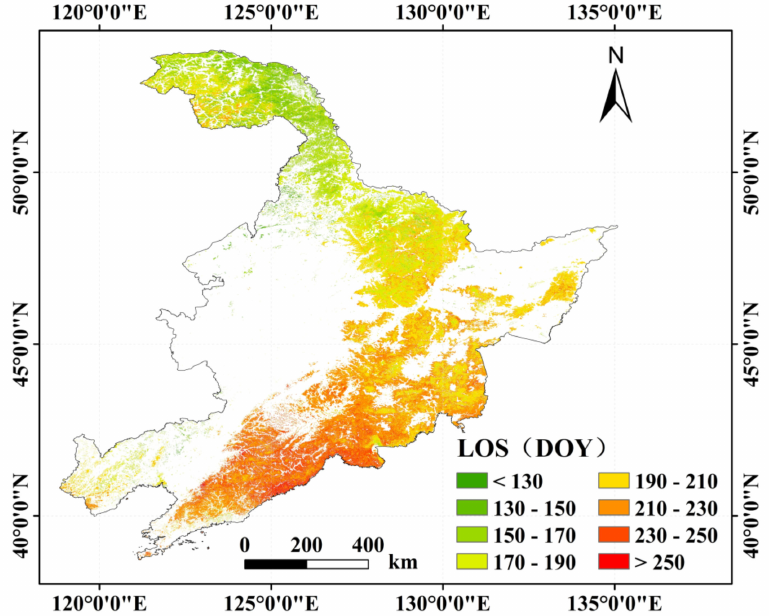
Figure 8. The spatial distribution of the average LOS (length of growing season) from 2011 to 2020 in the northeast